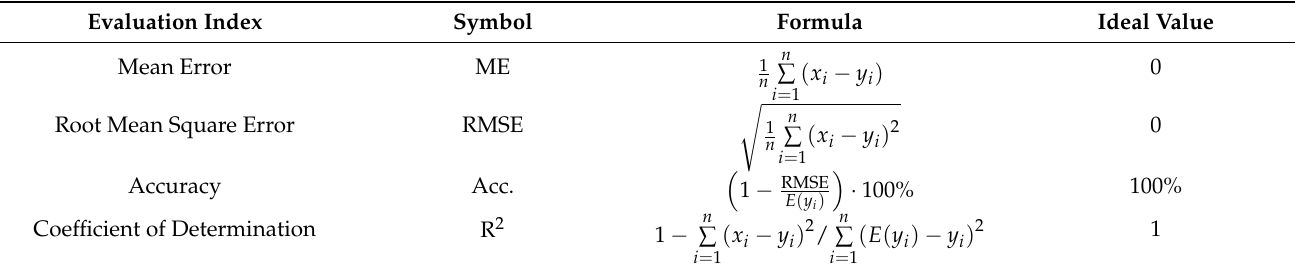
Table 1. The evaluation index used in this paper